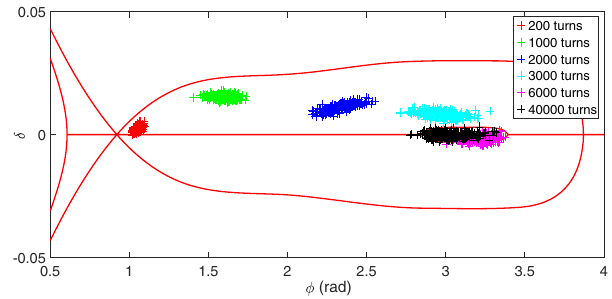
FIG. 7. Particle distribution in the longitudinal plane with up to 40000 turns, the bunch is injected at dt ¼ − 2 ns, dp ¼ 0